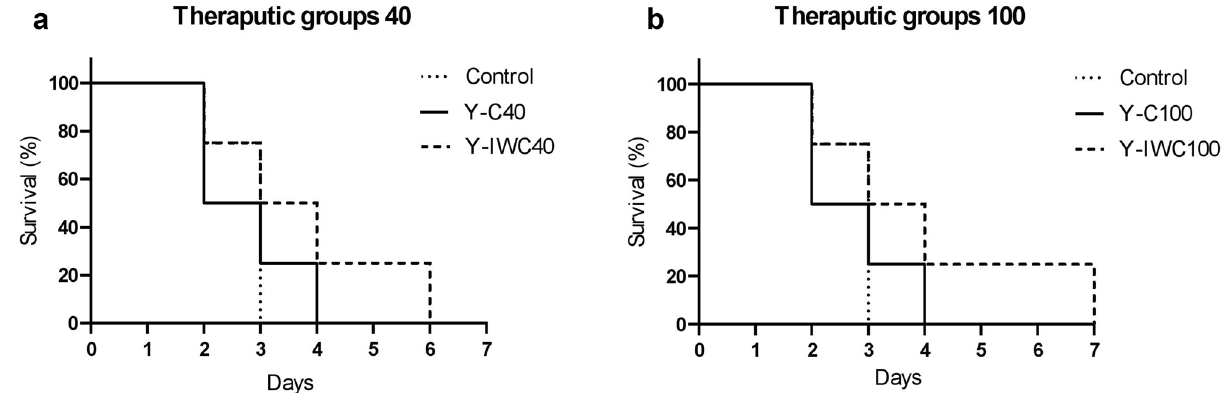
Figure 5. Survival plots of pilot mice groups. Mice groups received 40 µg ( a , Y-C40 and Y-IWC40) or 100 µg ( b , Y-C100 and Y-IWC100) of IgYs 4 h post-challenge with A. baumannii ATCC 19,606. Y-C: IgY-C, control IgY; Y-IWC: IgY-IWC, IgY raised against Inactivated Whole